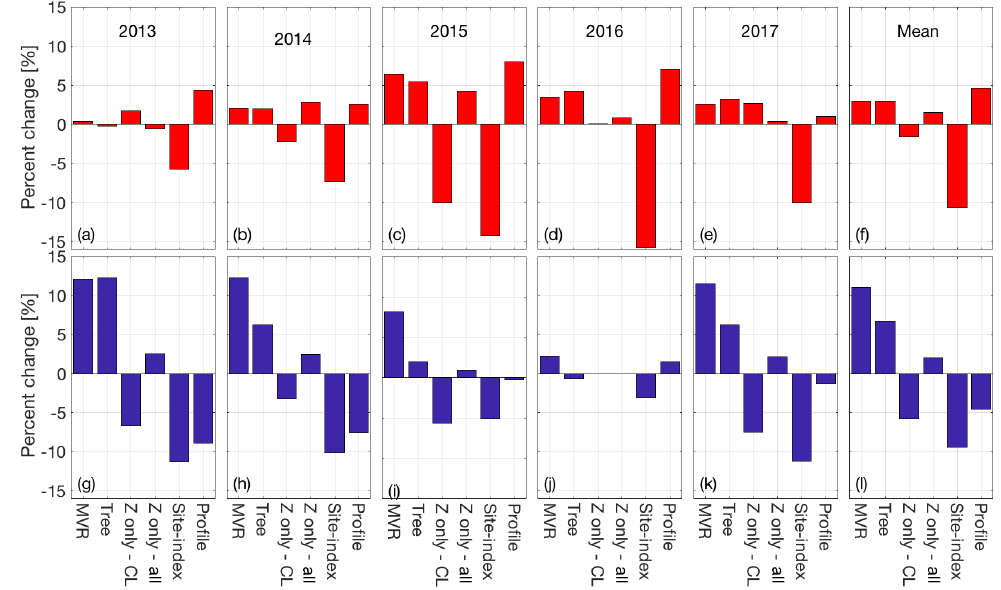
Figure 13. Percent deviation for each estimate from the six-method mean of B w . Individual years for Gulkana Glacier are shown in pan- els (a) – (e) with the 5-year mean shown in (f) . Individual years for Wolverine Glacier are shown in panels (g) – (k) , with the 5-year mean shown in (l) .